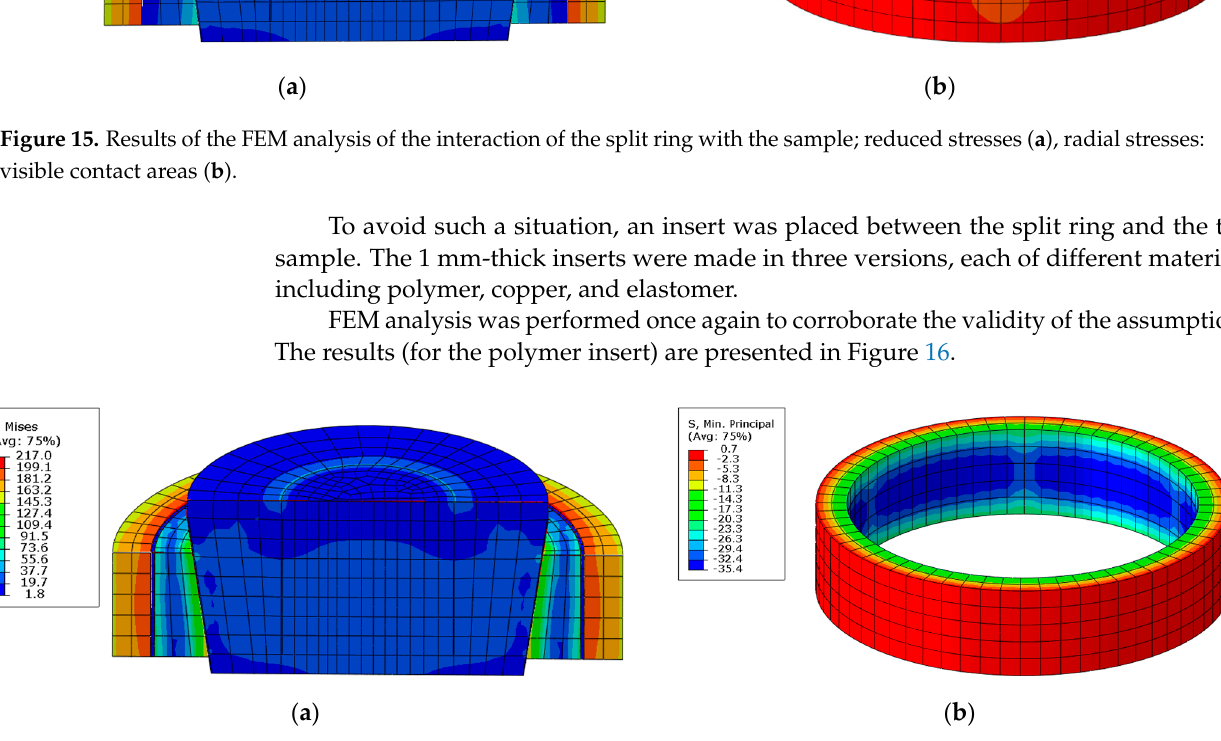
Figure 16. Results of the FEM analysis of the interaction of the split ring with the sample; reduced stresses ( a ), radial stresses: more favourable contact zone areas ( b ).